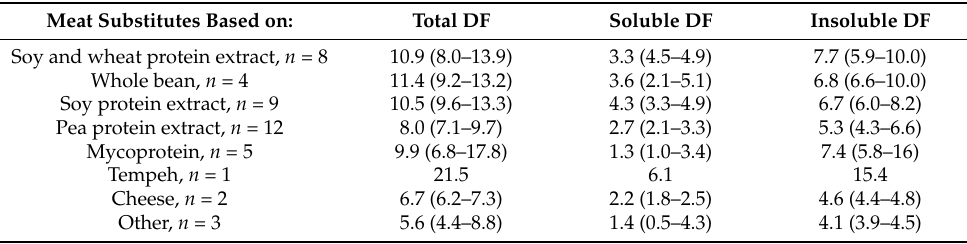
Table 6. Overview of total dietary fiber and the soluble and insoluble fractions of dietary fibers in meat substitutes, categorized according to the main protein source. Meat Substitutes Based on: Total DF Soluble DF Insoluble DF Soy and wheat protein extract, n =